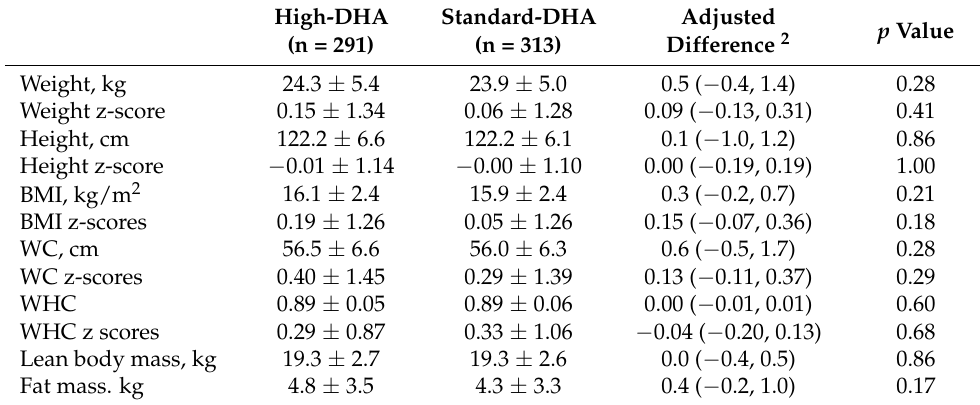
Table 2. Growth and body composition indicators at 7-year corrected age, by treatment group 1